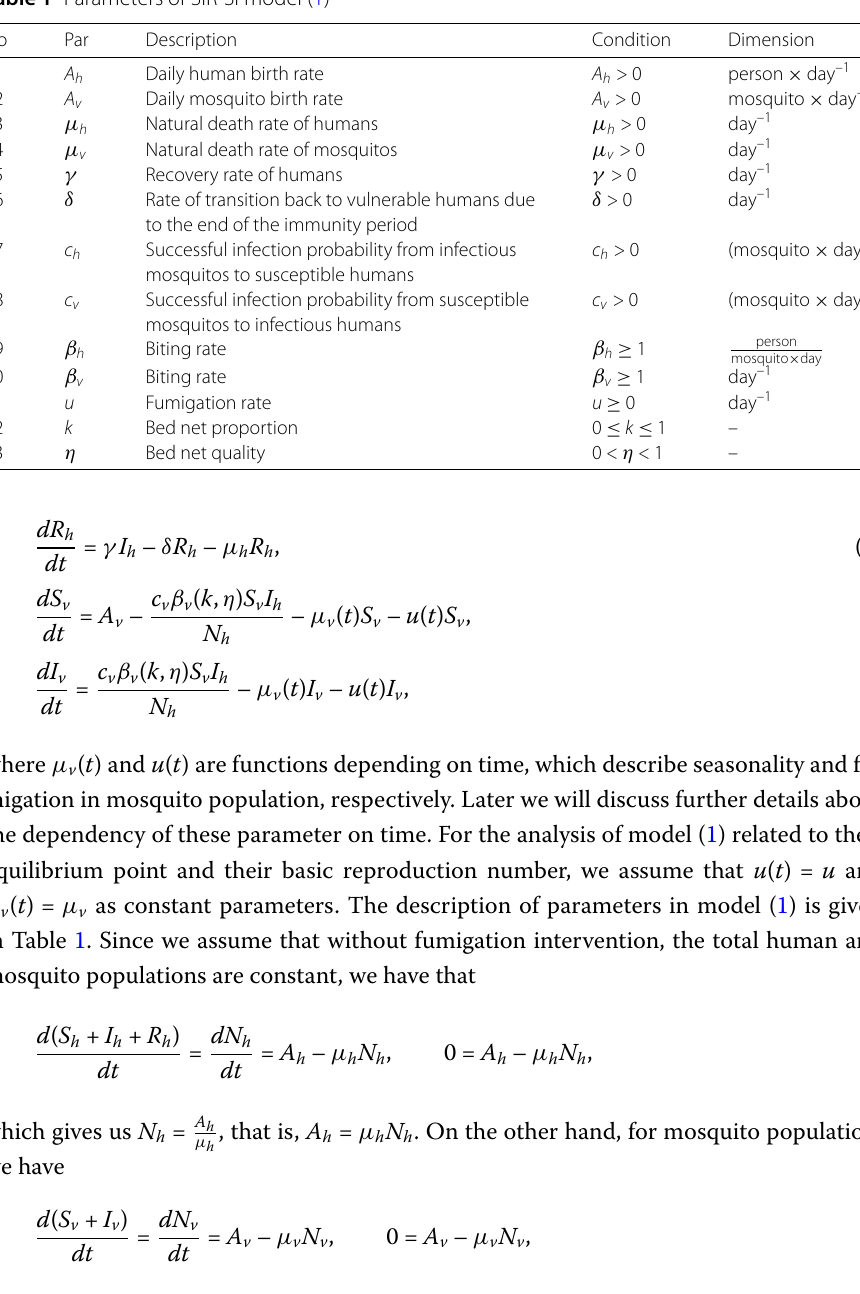
Table 1 Parameters of SIR-SI model